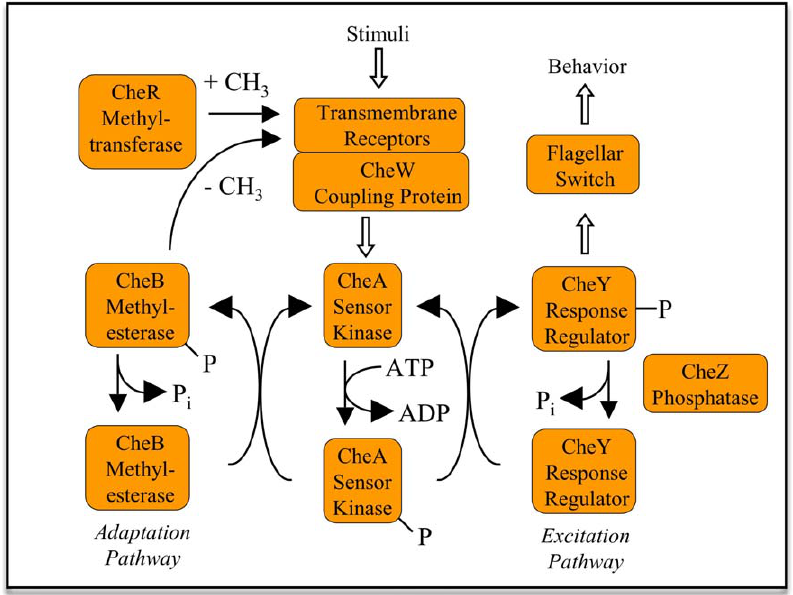
Figure 1. Schematic of the E.coli chemotaxis pathway, as described in the Introduction.